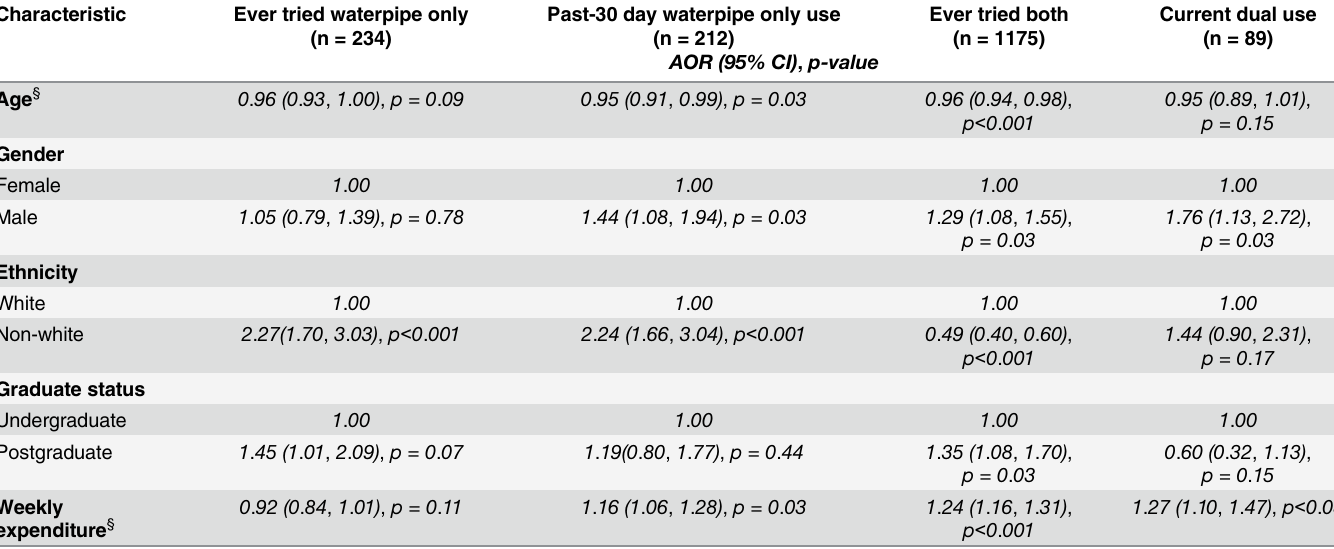
Table 3. Correlates of waterpipe tobacco smoking and dual use with cigarettes, by